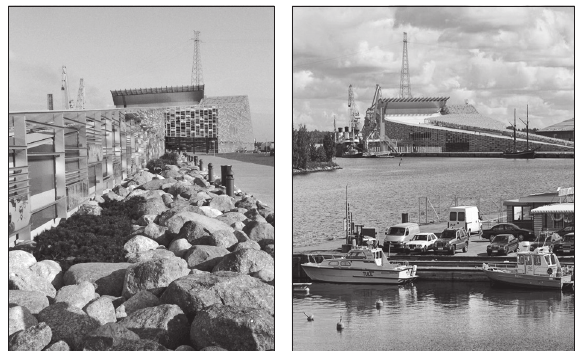
fig. 4. Port of Kotka